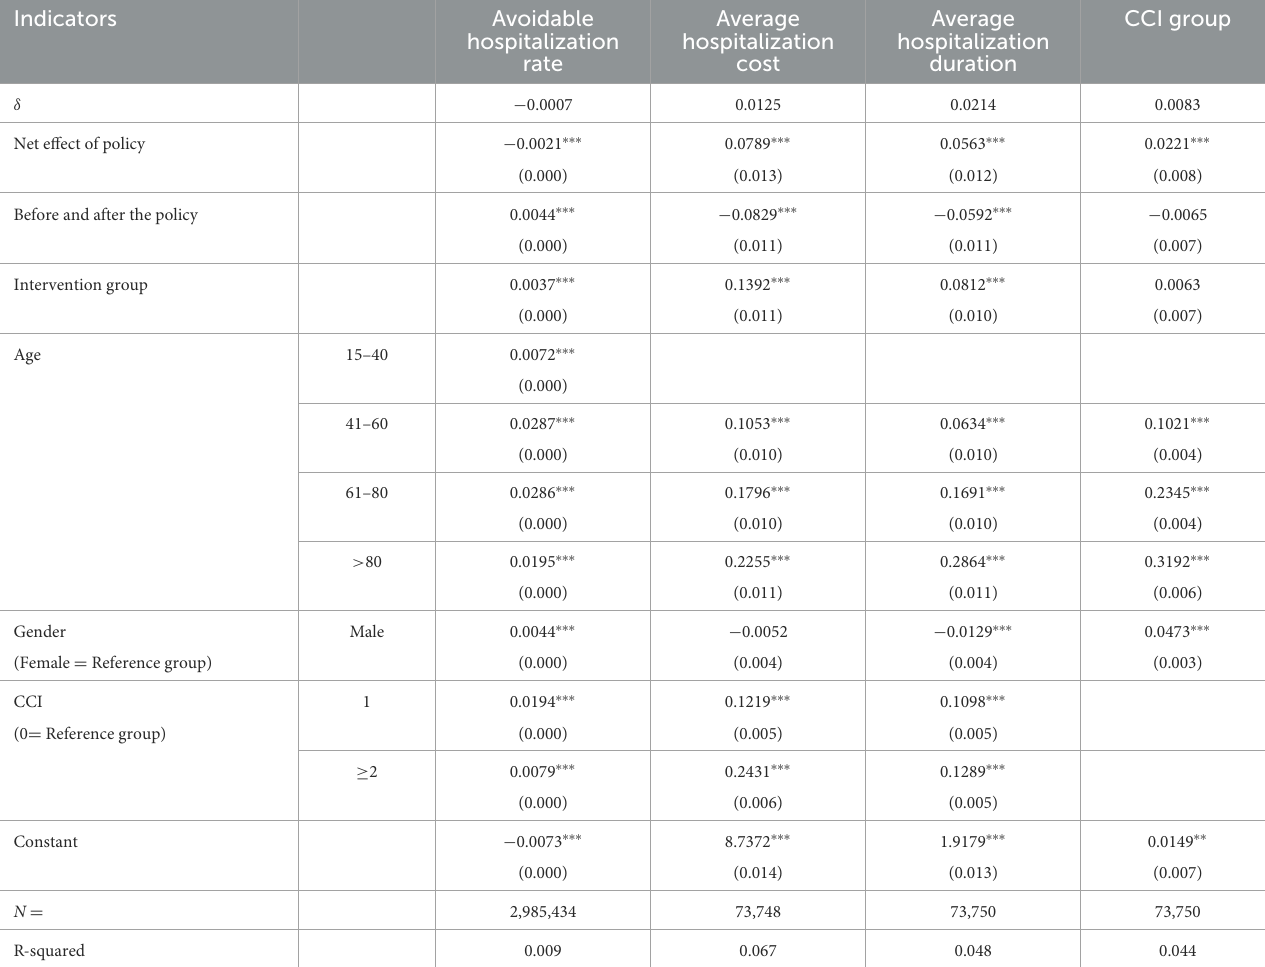
TABLE 3 Effects of policy change on avoidable hospitalization for diabetes mellitus (DID